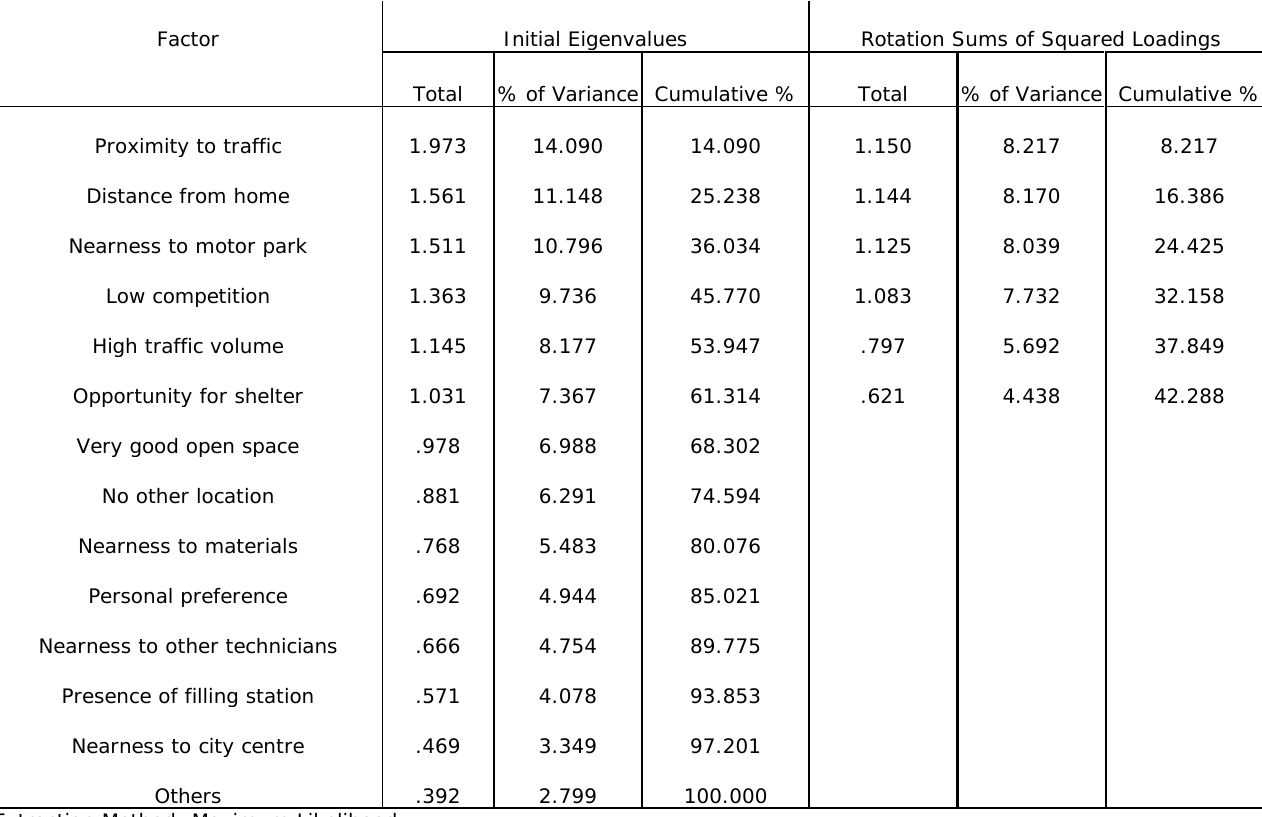
Table 2. Variance explained by each component